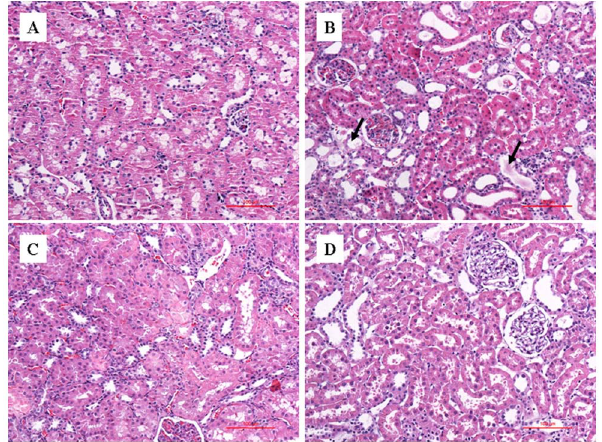
Figure 1. Representative HE-stained sections (200 fold) of kidneys from SO (A), UUO (B), CAO rats on 7 d (C) and 28 d (D), respectively. The SO rats exhibit no abnormal histopathological changes, whereas UUO rats display loss of brush border, tubular swelling atrophy and cystic dilation. Meanwhile, CAO rats display the different therapeutic effects of the